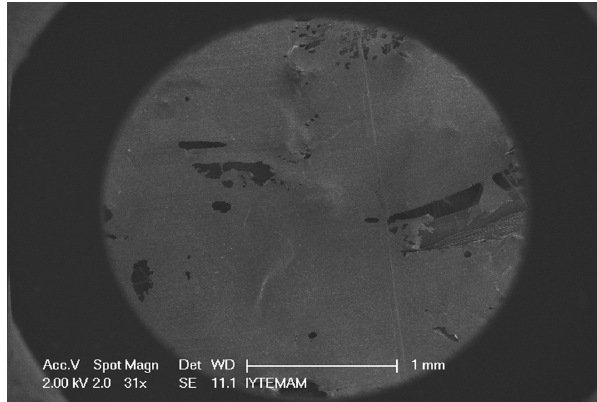
Figure 5 Microscopic surface photograph of the knitted fabric- reinforced composites by